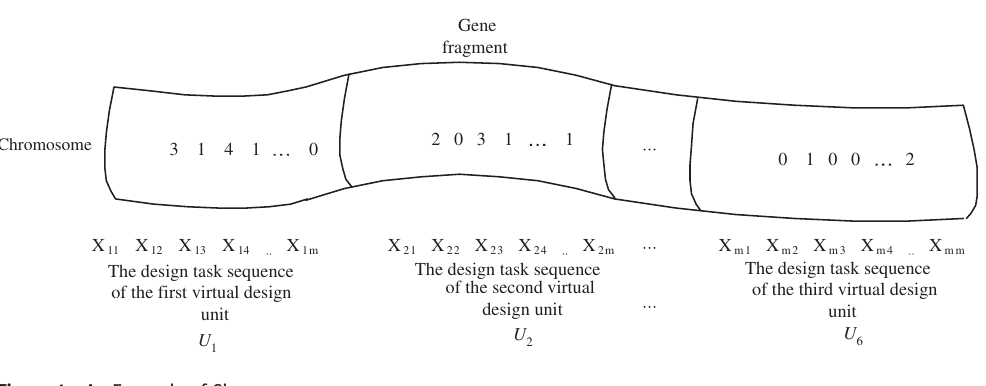
Figure 4: An Example of